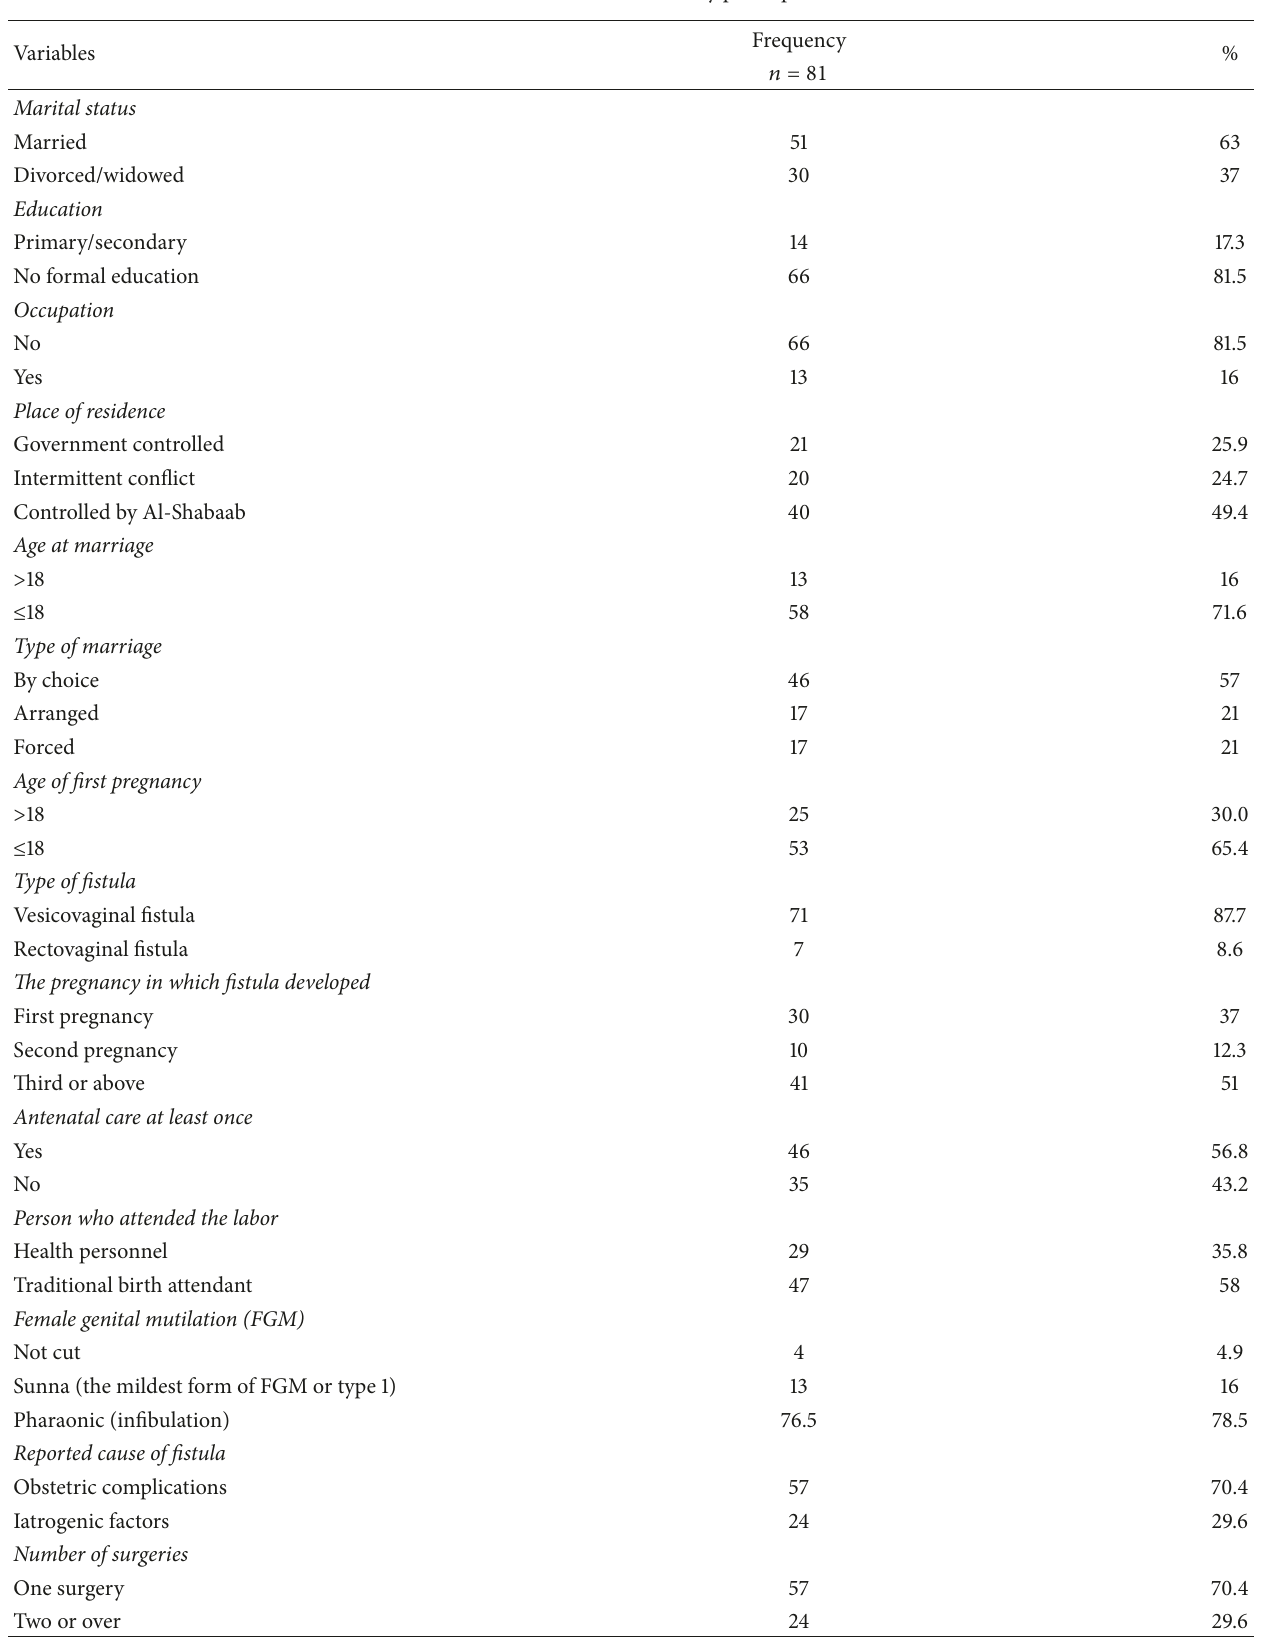
Table 1: Characteristics of study